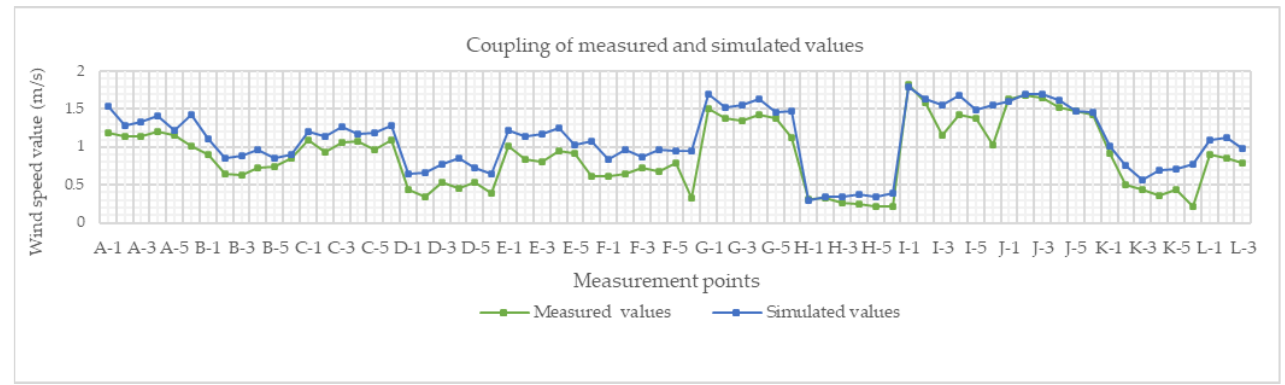
Figure 10. Line graph of the values of the measured and CFD simulated points. The data for the graph were obtained through CFD simulations.